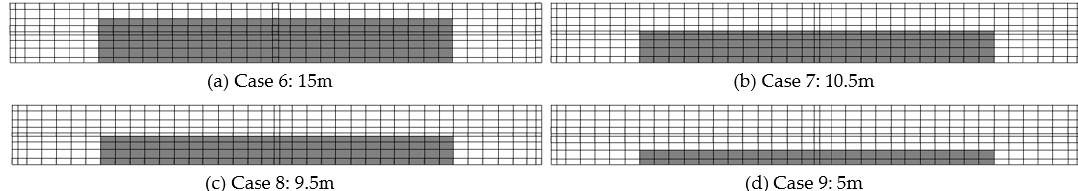
Figure 19. Four fracture profiles with different propped fracture heights (gray: propped; white: unpropped).